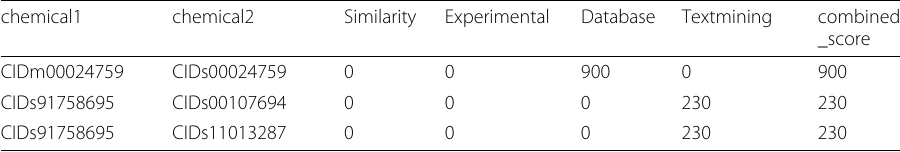
Table 2 Examples for metabolites interactions extracted from the open STRING database: used to construct metabolites layer chemical1 chemical2 Similarity Experimental Database Textmining